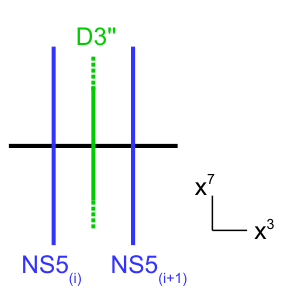
Figure 39 . Setup with a D3" brane crossing the D3